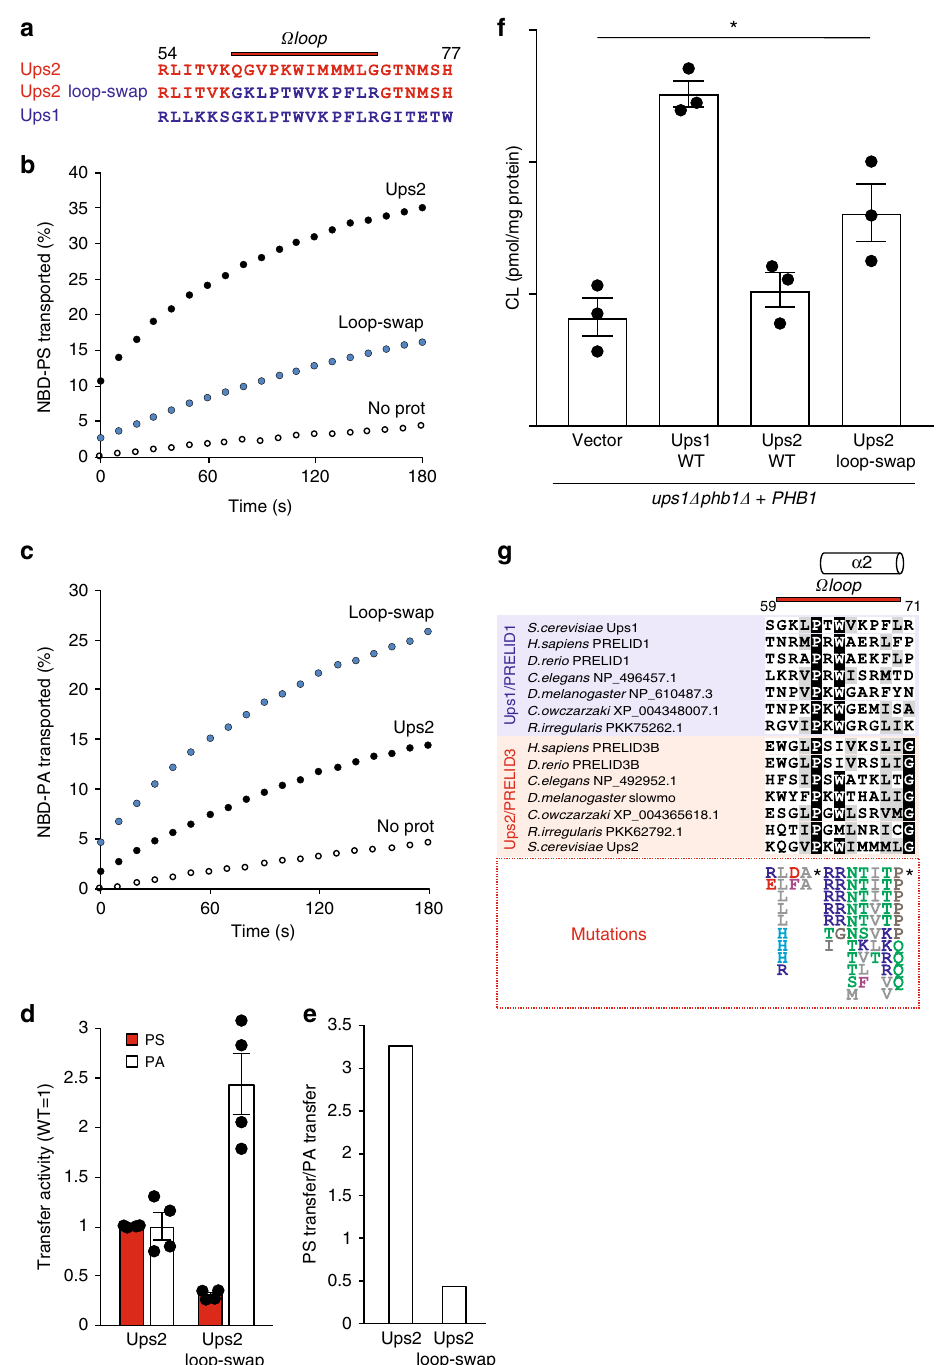
Fig. 6 Lipid transfer speci fi city of Ω loop mutants of Ups1 and Ups2. a Amino acid sequence of the region surrounding the Ω loop in Ups1 and Ups2 and of the Ups2 loop-swap mutant. b PS transfer by Ups2 and loop-swap variant. The Ω loop was exchanged in a truncated version of Ups2 ( Δ 174) that is functionally active but shows reduced tendency to aggregate in vitro (Supplementary Figure 6A). Recombinant protein complexes (50 nM) were incubated with donor liposomes (12.5 µ M) containing NBD-PS and Rhodamine-PE (PC/PE/CL/Lac-PE/NBD-PS/Rhodamine-PE = 50/23/15/5/5/2 mol%) and acceptor liposomes (50 µ M; PC/PE/CL/Lac-PE/PS = 50/25/15/5/5 mol%) at 25 °C and NBD fl uorescence was monitored. c PA transfer by Ups2 and the Ups2 loop-swap variant. Recombinant protein complexes (50 nM) were incubated with donor liposomes (12.5 µ M) containing NBD-PA and Rhodamine-PE (PC/PE/CL/Lac-PE/NBD-PA/Rhodamine-PE = 50/23/15/5/5/2 mol%) and acceptor liposomes (50 µ M; PC/PE/CL/Lac-PE/PA = 50/25/15/5/5mol%) at 25 °C and NBD fl uorescence was monitored. d PS and PA transfer activities of the Ups2 loop-swap variant normalised to control. Error bars represent mean ± SEM, n = 4. e PS/PA transfer activity ratio of Ups2 and the loop-swap variant. f Total CL levels in ups1 Δ phb1 Δ cells expressing Phb1 and Ups1, Ups2 or Ups2 loop-swap. N = 3. Error bars represent mean ± SEM. * p < 0.05. g Sequence alignment of Ω loop regions of members of the Ups1/PRELID1 and Ups2/PRELID3b subfamilies in the indicated eukaryotic organisms. Mutations in Ω loop of Ups2 that were identi fi ed in the genetic screen are indicated below. Asterisks refer to the residues that were not found